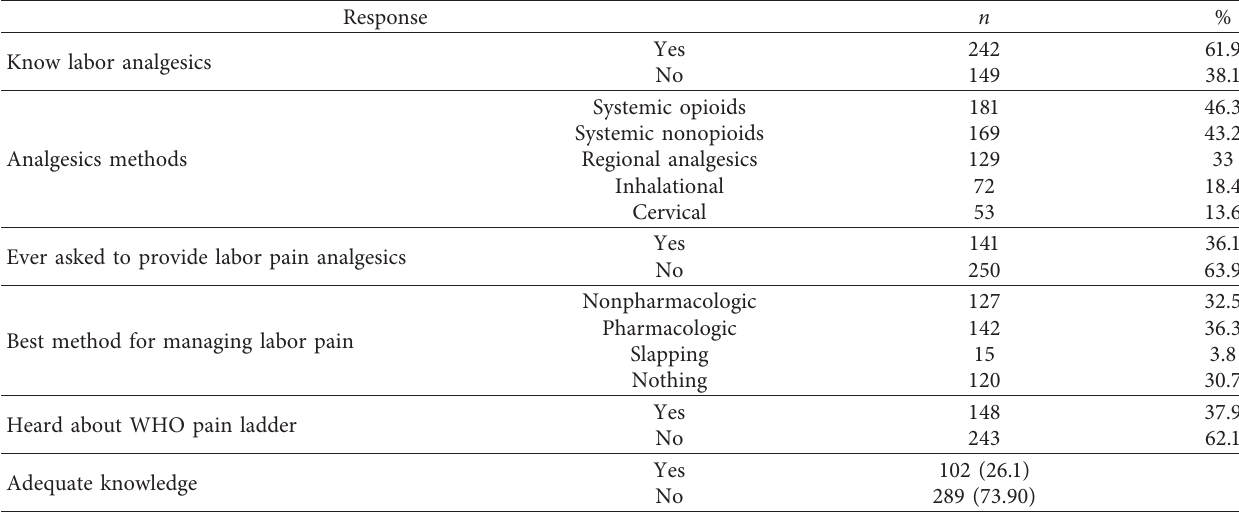
Table 3: Knowledge on obstetric analgesia among obstetric care providers in public hospitals of Addis Ababa, Ethiopia, 2020 ( n � 391).